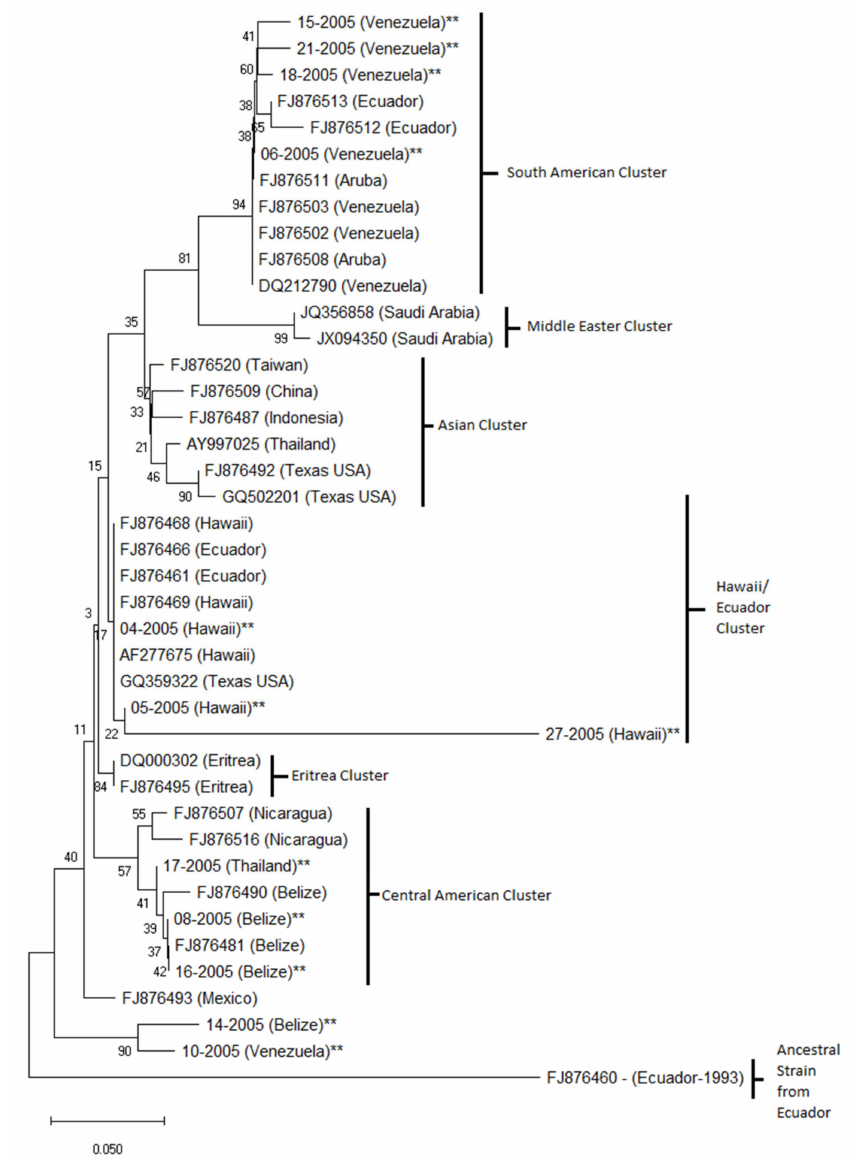
Figure 6. Phylogenetic analysis of TSV isolates. The evolutionary history was inferred using the neighbor-joining method. The optimal tree with the sum of branch length = 0.87629497 is shown. The percentage of replicate trees in which the associated taxa clustered together in the bootstrap test (1000 replicates) are shown next to the branches. The tree is drawn to scale with branch lengths in the same units as those of the evolutionary distances used to infer the phylogenetic tree. The evolutionary distances were computed using the Maximum Composite Likelihood method and are in the units of the number of base substitutions per site. This analysis included 12 samples from the present study (denoted by ** on the tree) and 29 GenBank